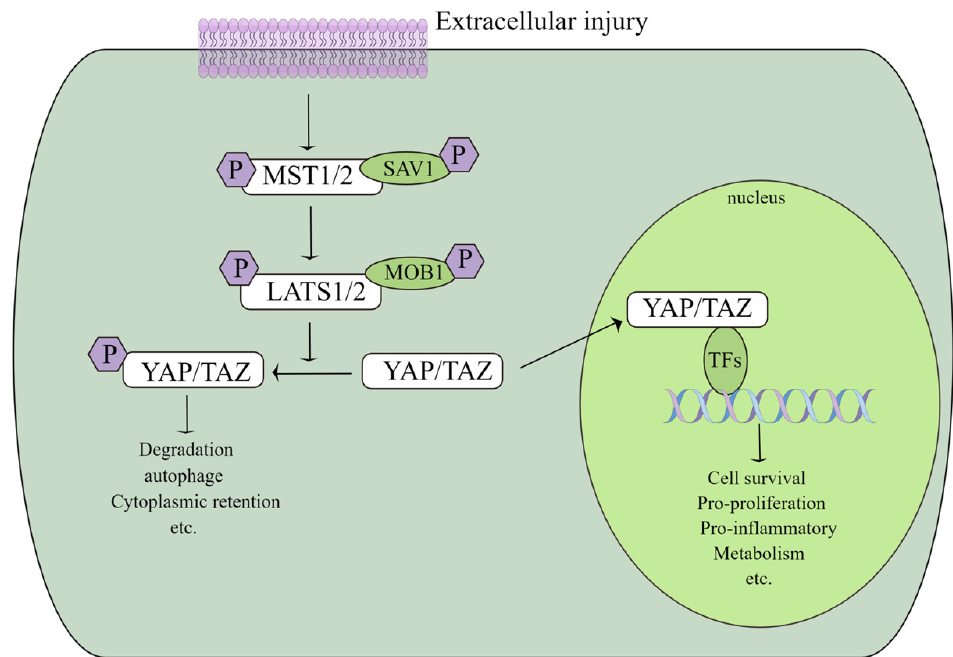
Figure 1. Mechanism of the YAP/TAZ signaling protein.